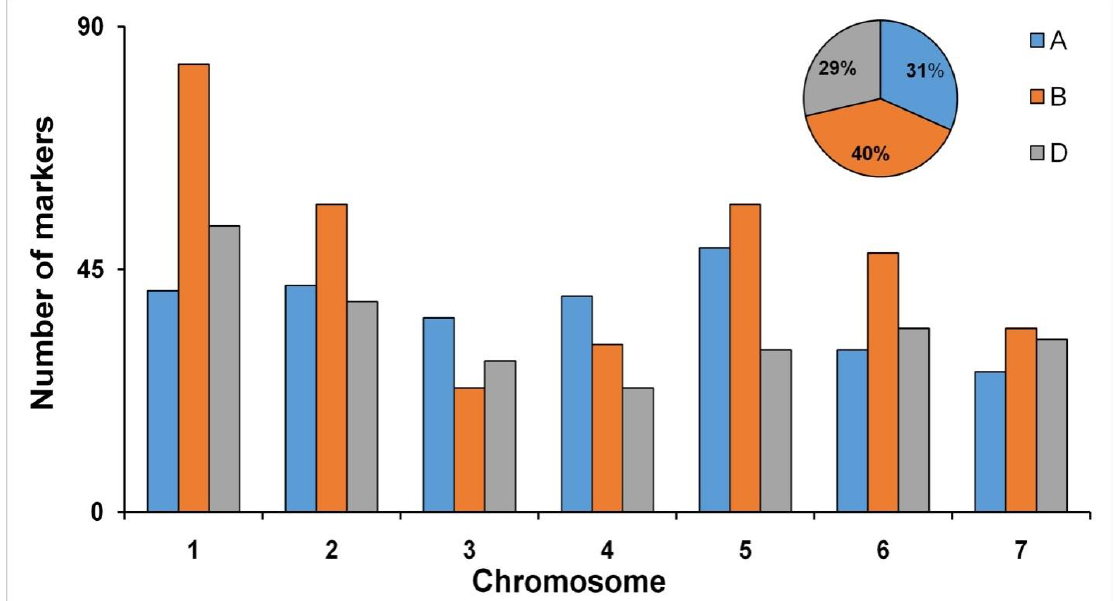
Figure 4. Histogram for the number of polymorphic markers distributed across chromosomes; pie- chart represents the percentage of marker distributed on A, B, and D genome. Blue colour indicates A genome; Orange colour indicates B genome; Grey colour indicates C genome.